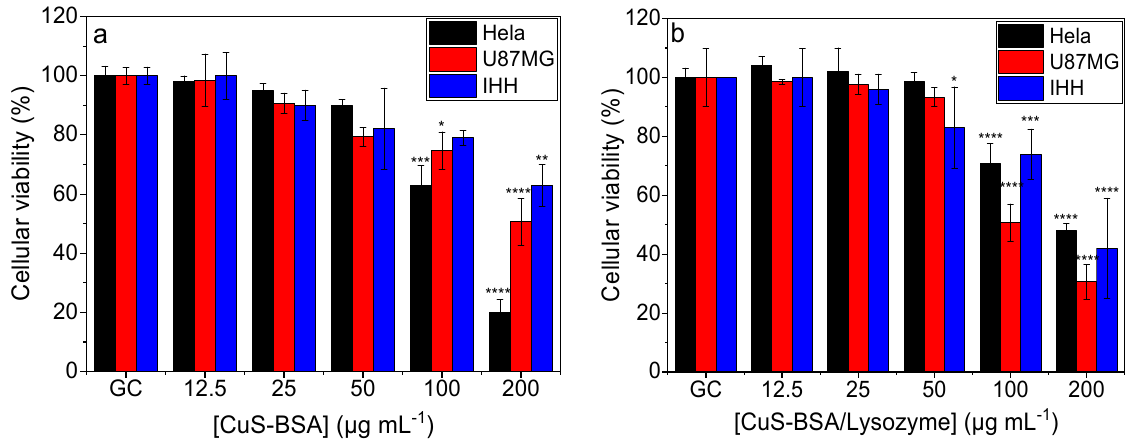
Figure 6. Cellular viability of ( a ) CuS-BSA and ( b ) CuS-BSA/lysozyme at various concentrations (0–200 µg mL − 1 ) under 980 nm (1 W cm − 2 , 3 min) illumination on different cell lines. * p < 0.05, ** p < 0.01, *** p < 0.001, **** p < 0.0001. In order to preclude the cell killing efficiency under the influence of NIR irradiation, cells were also illuminated at 1 W cm − 2 in the absence of nanoparticles. Under these conditions, the cell viability remained at 100%, indicating that the tested cell lines are not sensitive to NIR laser irradiation, and the obtained cell killing was attributed to the photothermal heating effect of the nanoparticles (Figure